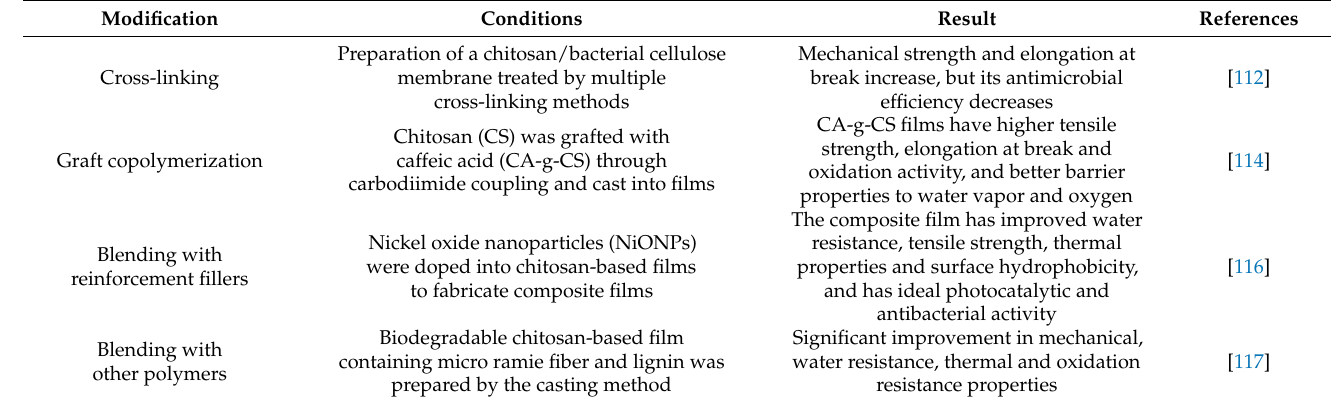
Table 6. The different modifications of Chitosan-based film